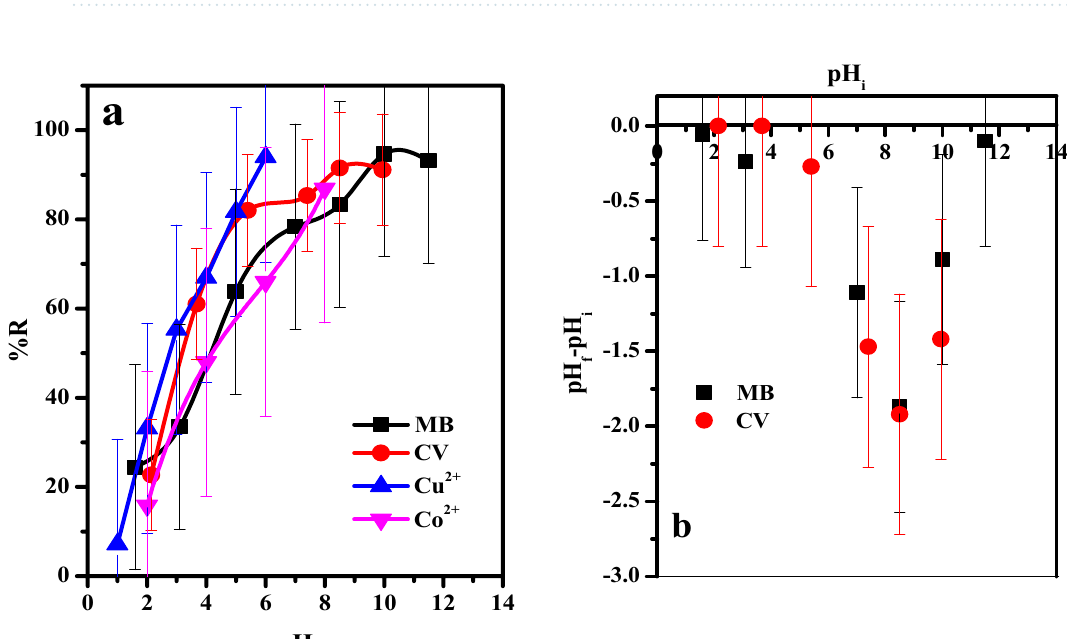
Figure 7. ( a ) Effect of the initial solution pH on The removal percentage (% R) from aqueous solution, ( b ) pH ZPC of the GO–C adsorbent of MB-dye (t = 5 min, [MB] = 30 ppm, dose = 6 mg, v = 50 ml, T = 30 °C) and CV-dye (t = 7 min, [CV] = 30 ppm, dose = 6 mg, v = 50 ml, T = 30 °C), Cu 2+ ([Cu 2+ ] = 50 mg l −1 , Dose = 2.4 mg, v = 5 ml, T = 25 °C) and Co 2+ (t = 1 min, [Co 2+ ] = 50 mg l −1 , Dose = 2.4 mg, v = 5 ml, T = 25 °C) form aqueous